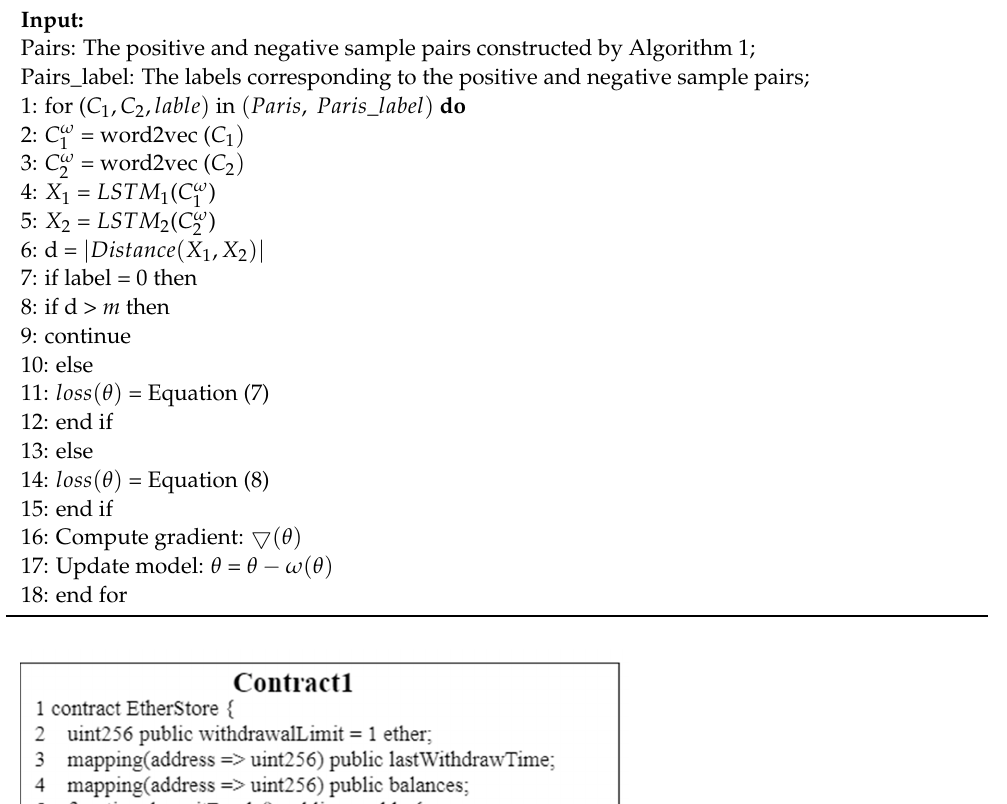
Algorithm 2 . training process of the SCVSN model